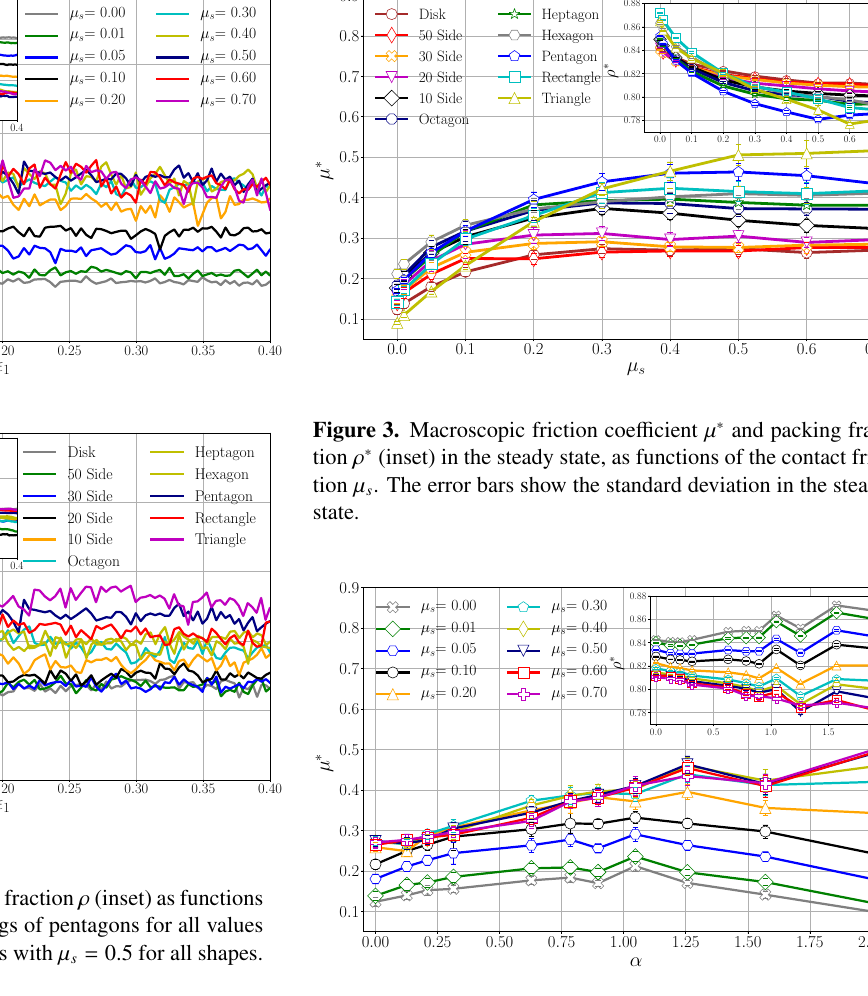
Figure 4. Macroscopic friction coe ffi cient µ ∗ and packing frac- tion ρ ∗ (inset) in the steady state, as functions of the particle an- gularity α . The error bars show the standard deviation in the steady